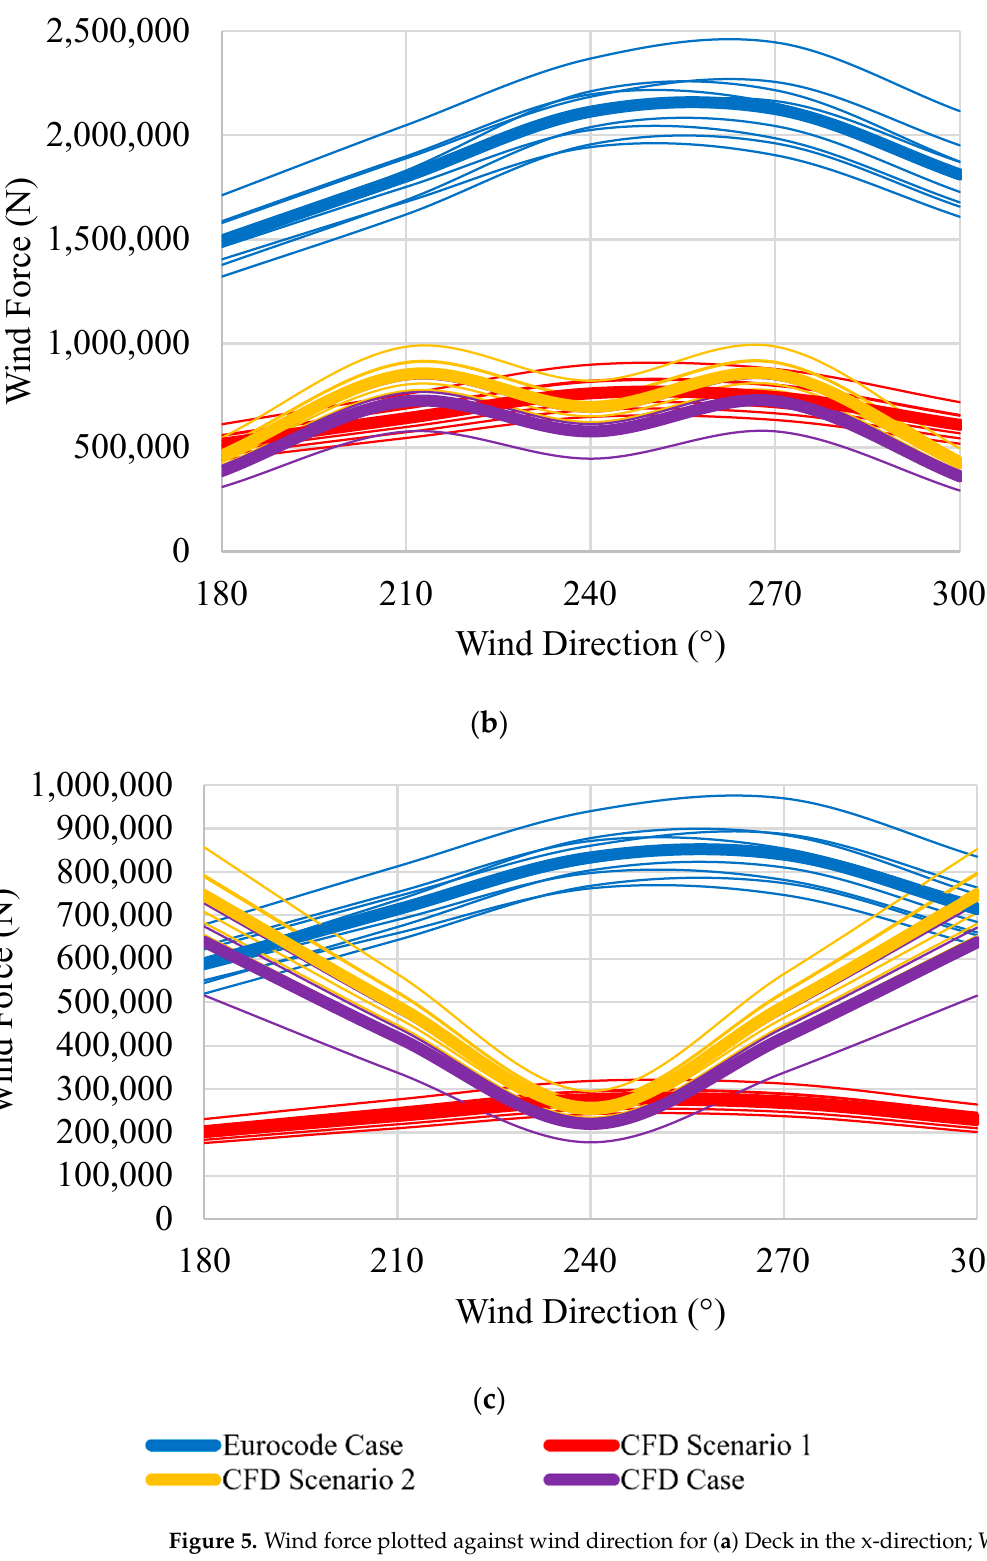
Figure 5. Wind force plotted against wind direction for ( a ) Deck in the x-direction; Wind force acting on the deck in the x-direction; ( b ) Deck in the z-direction; Wind force acting on the deck in the z-direction; ( c ) Piers in the x-direction; Wind force acting on the piers in the x-direction. Both the Eurocode Case and CFD Case 1 followed the same shape trend for the deck in the x- and z-directions and the piers in the z-direction. Thus, the Eurocode does not